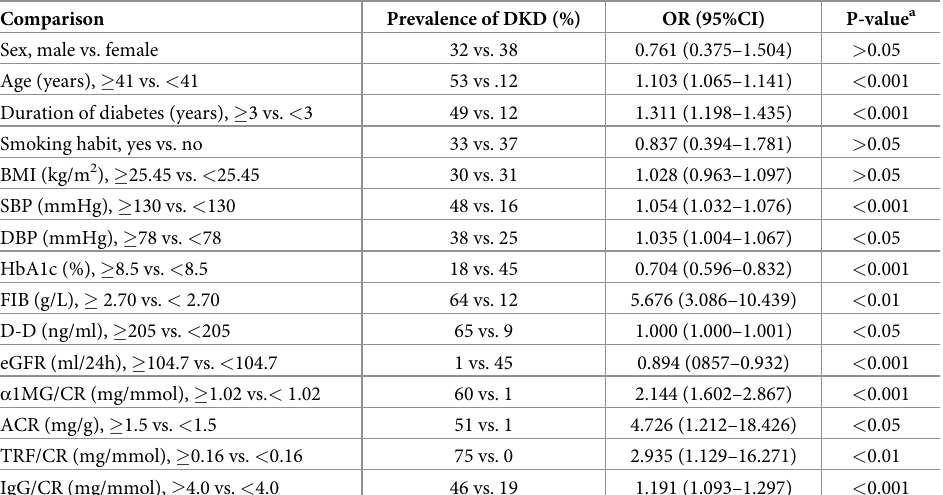
Table 2. Incidence and univariate analysis of DKD in different characteristics of T2D patients. Comparison Prevalence of DKD (%) OR (95%CI) P-value a Sex, male vs. female 32 vs. 38 0.761 (0.375–1.504) > 0.05 Age (years), � 41 vs. < 41 < 0.001 Duration of diabetes (years), � 3 vs. < 3 49 vs. 12 Smoking habit, yes vs. no